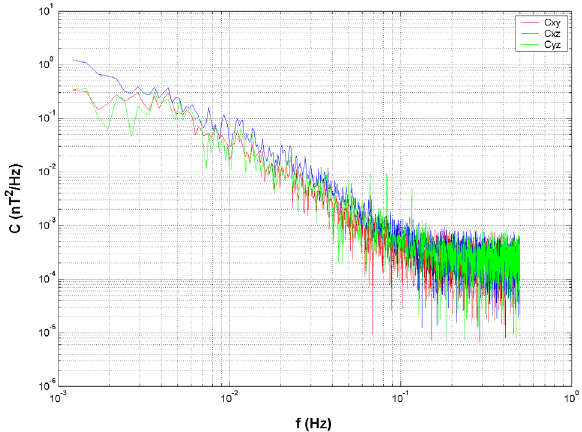
Figure 8. Cross spectra between the three components of geo- magnetic field.